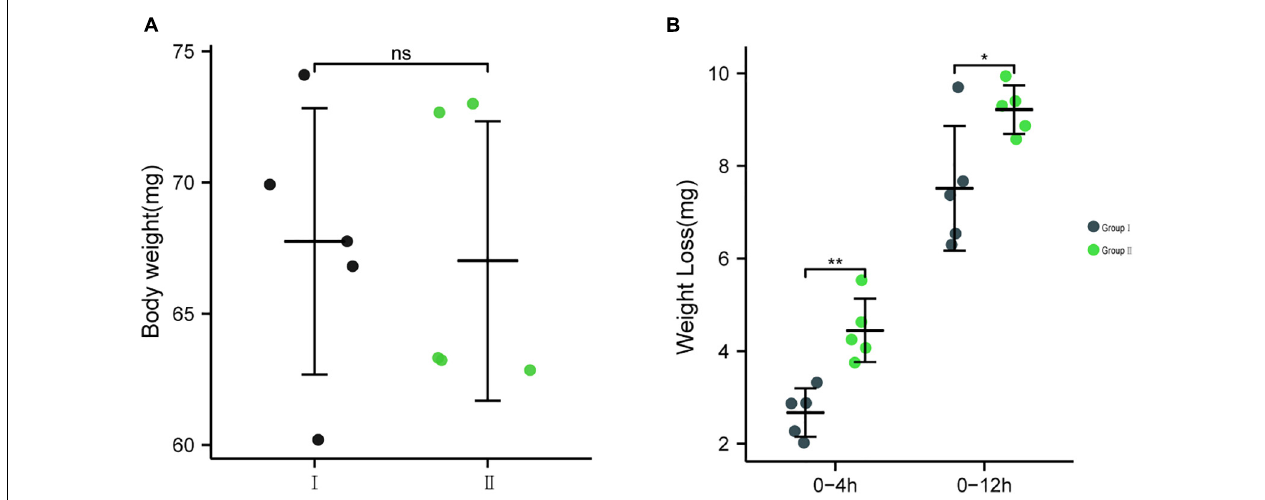
FIGURE 9 | (A) The body weights of the two groups of insects before starvation, (B) The effect of feeding EG-Q3 on body mass. Independent sample t -tests were used to evaluate significance. Data are presented as mean ± SD ( n = 5). * indicates significance difference between two groups: *, p < 0.05; **, p < 0.01.